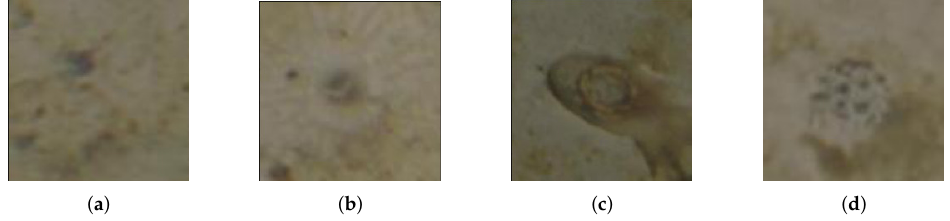
Figure 1. Γ PAP dataset. ( a ) Ophiuroidea; ( b ) Cnidaria; ( c ) Amperima; ( d ) Foraminifera. Reproduced with permission from Henry Ruhl.